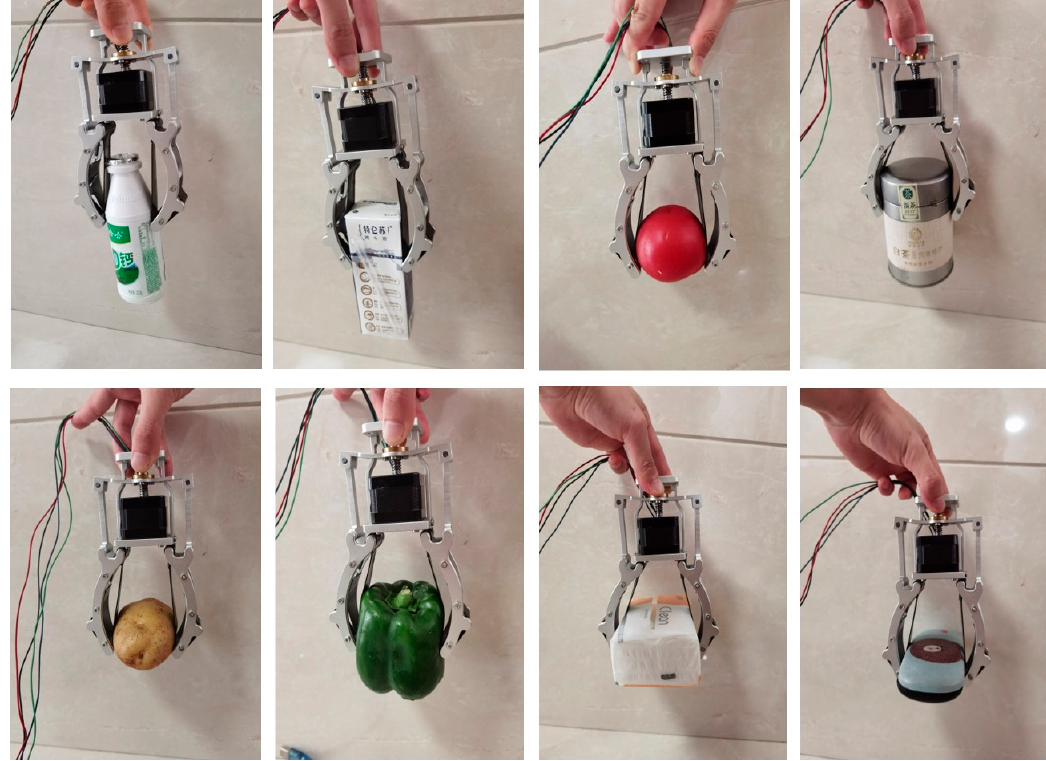
Figure 10. Grasping objects of different shapes in daily life (plastic bottle, milk box, tomato, green pepper, and so on).